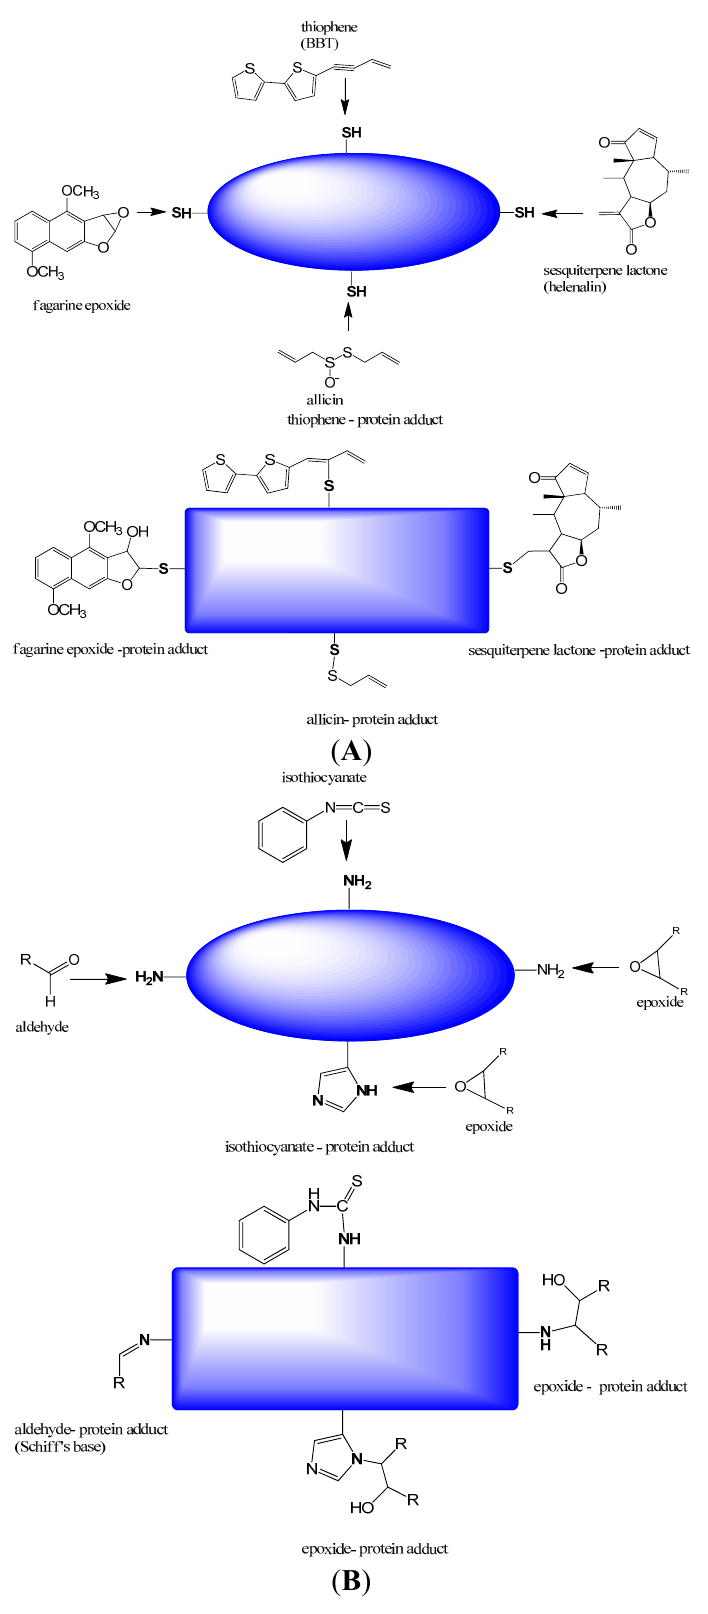
Figure 1. Secondary metabolites (SM) which form covalent bonds with proteins inducing a conformational change (indicated by the change of the form of the theoretical protein) and thus modulating their bioactivities (after [51,63]). ( A ) Interactions of SM with SH-groups of proteins and peptides; ( B ) Interactions of SM with amino groups of proteins or